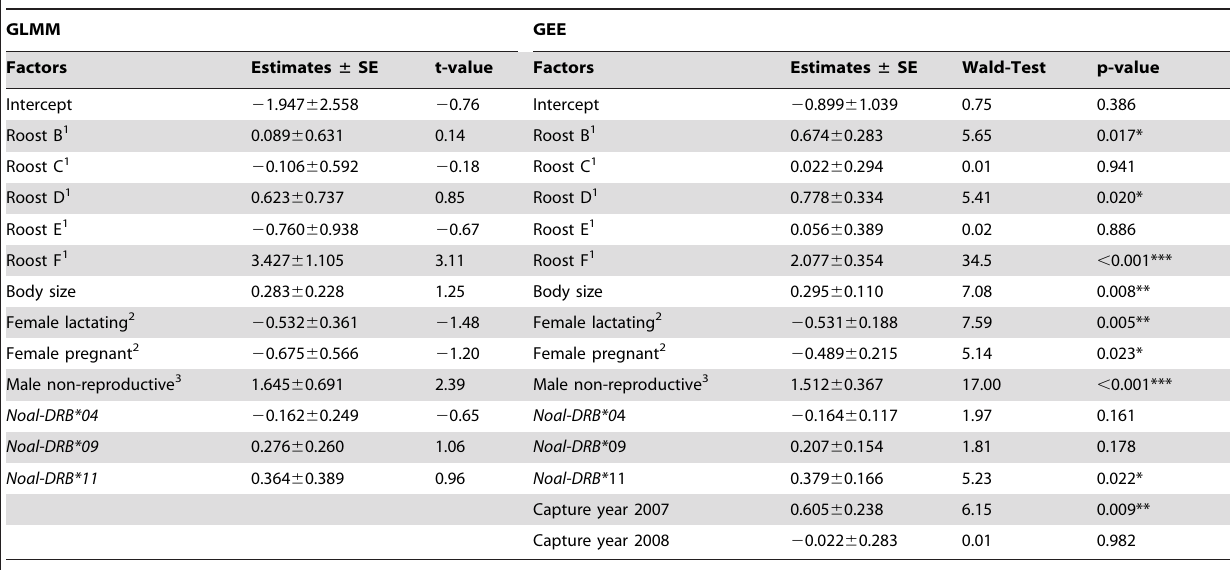
Table 3. Bat fly infestation in N. albiventris